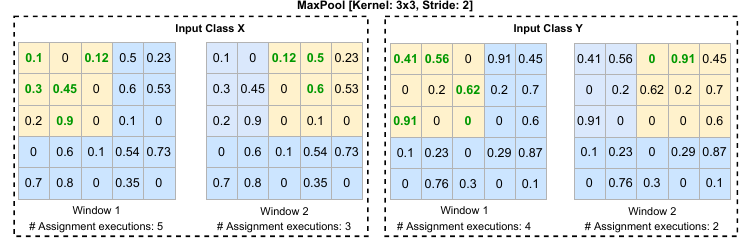
Figure 5: An example of varying number of if statement calls for two different windows (Kernels) during Maxpool operation